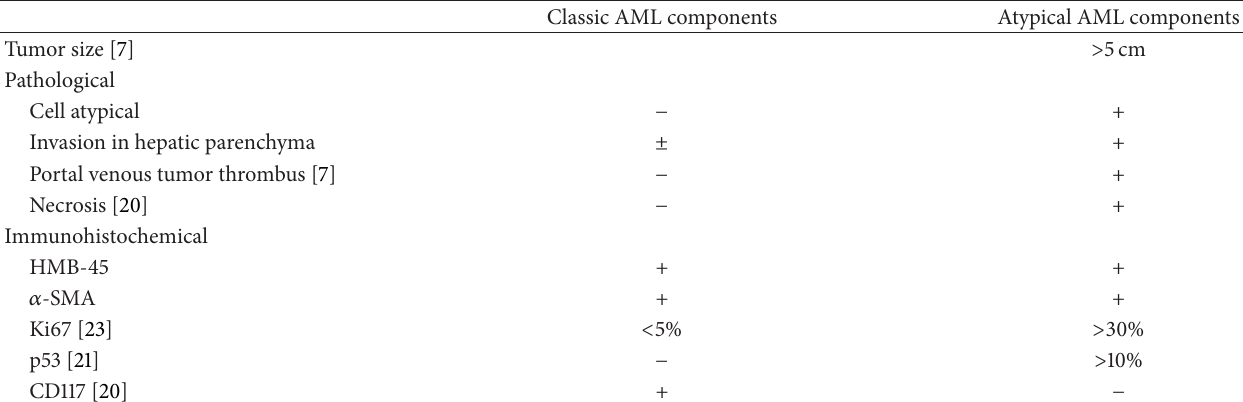
Table 1: Characteristics for malignant AML.